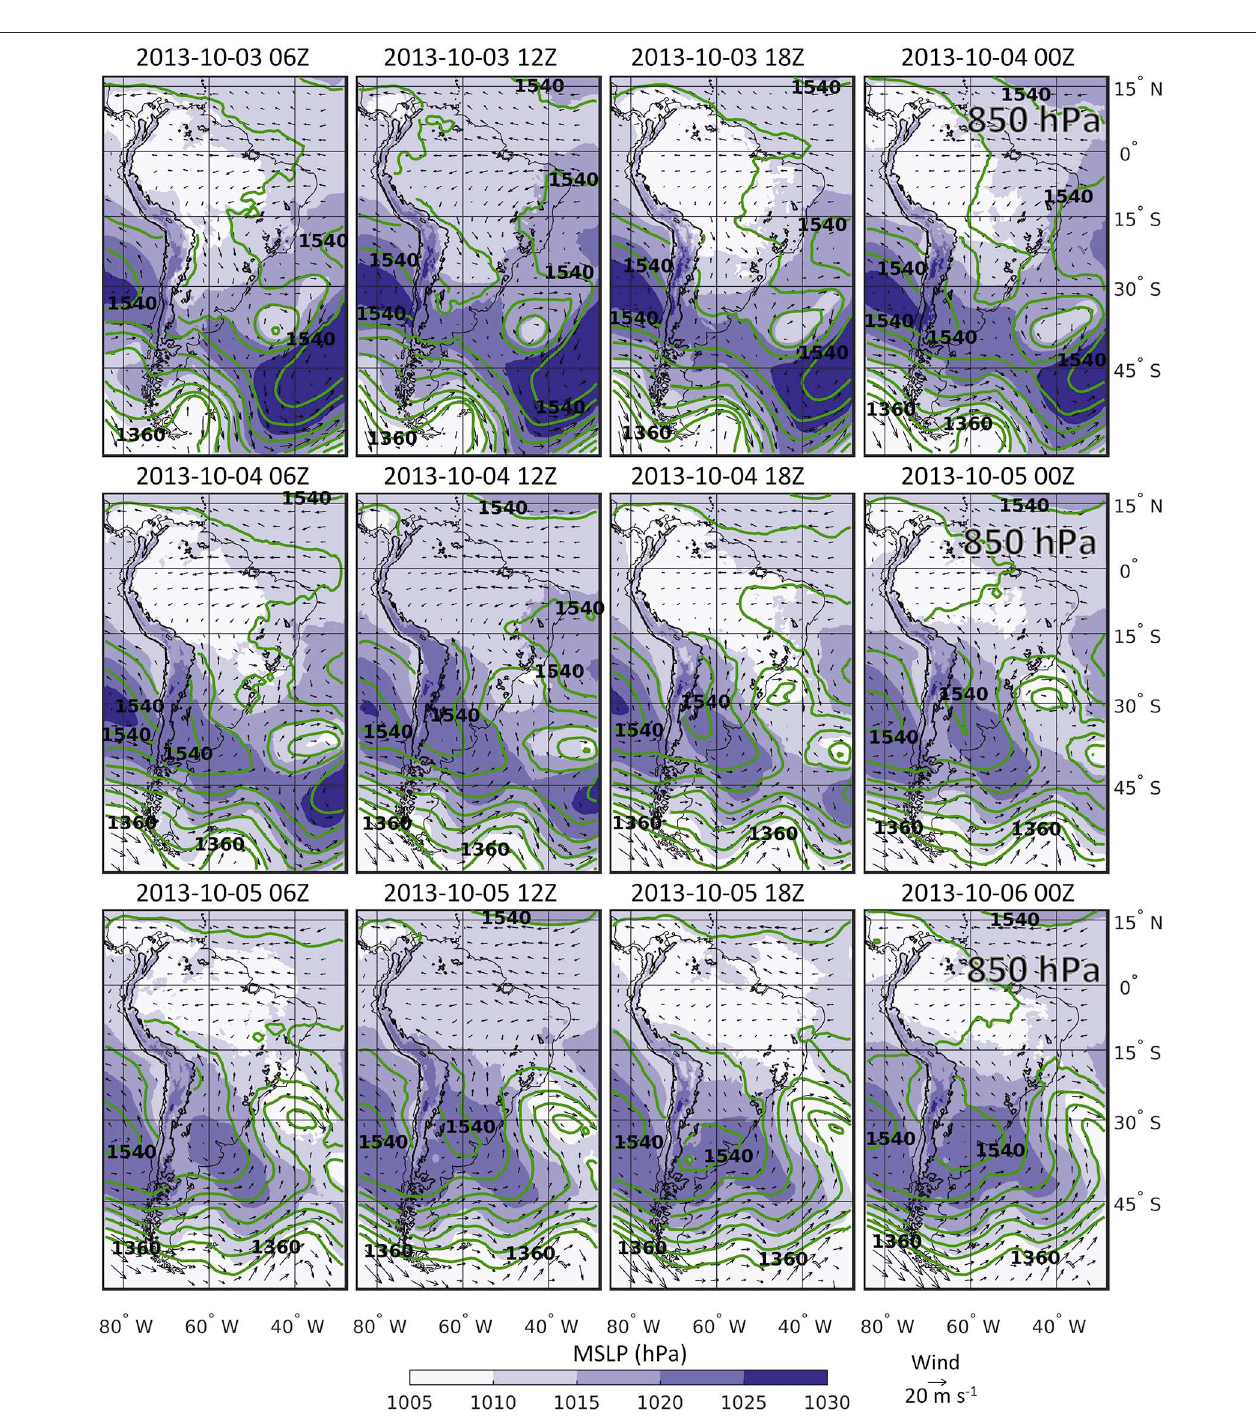
FIGURE 4 | WRF simulation ( D 01, 18 km ) of the October 4, 2013 CAI case study. The maps show Mean Sea Level Pressure ( MSLP , shaded), 850 hPa level horizontal winds (arrows), and 850 hPa geopotential heights (green contours, 30m interval) every 6h starting on October 3 at 06Z. The black contour line shows the 2000 m